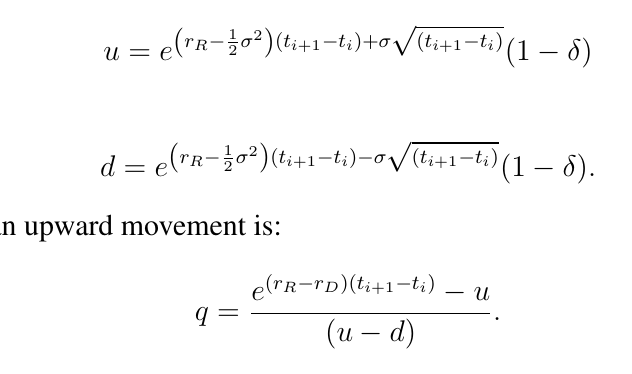
= 0 . 04 , r = 0 . 05 , r = 0 . 06 , r = 0 . 01 , C R F D